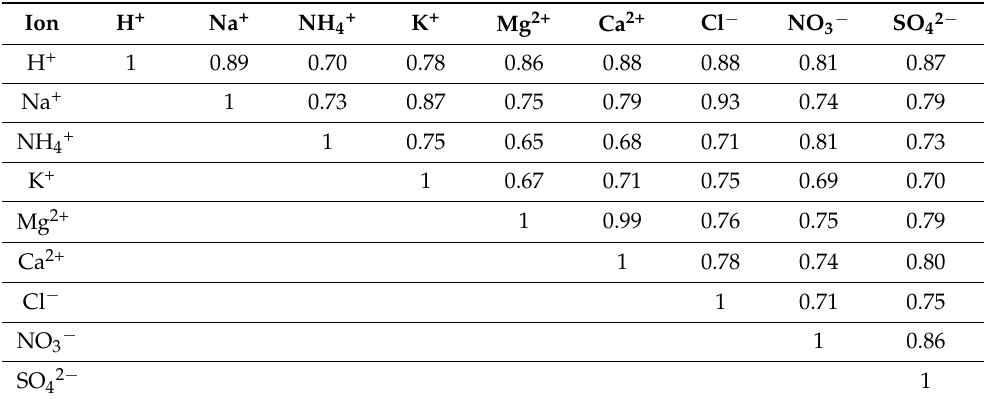
Table 2. Correlation matrix of ionic for low ion concentrations (<1.5 µ g/m 3 ) in the atmospheric aerosol of the Bolshiye Koty research station in 2020.